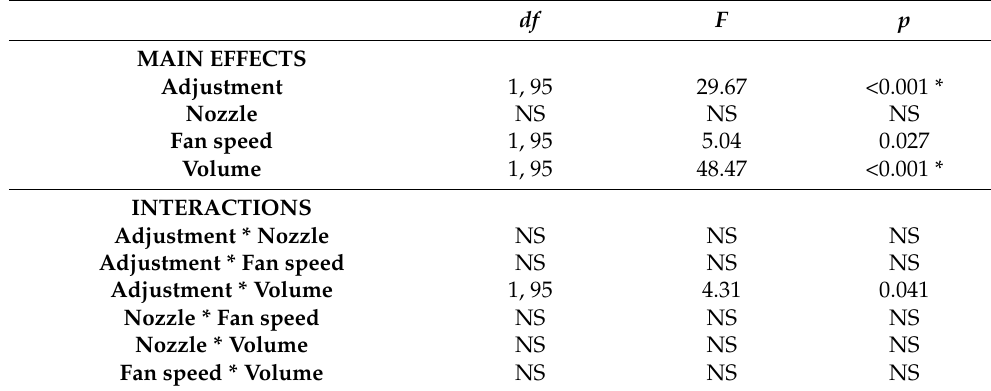
Table 6. Two-way ANOVA results for the normalized volume collected above the Canopy height